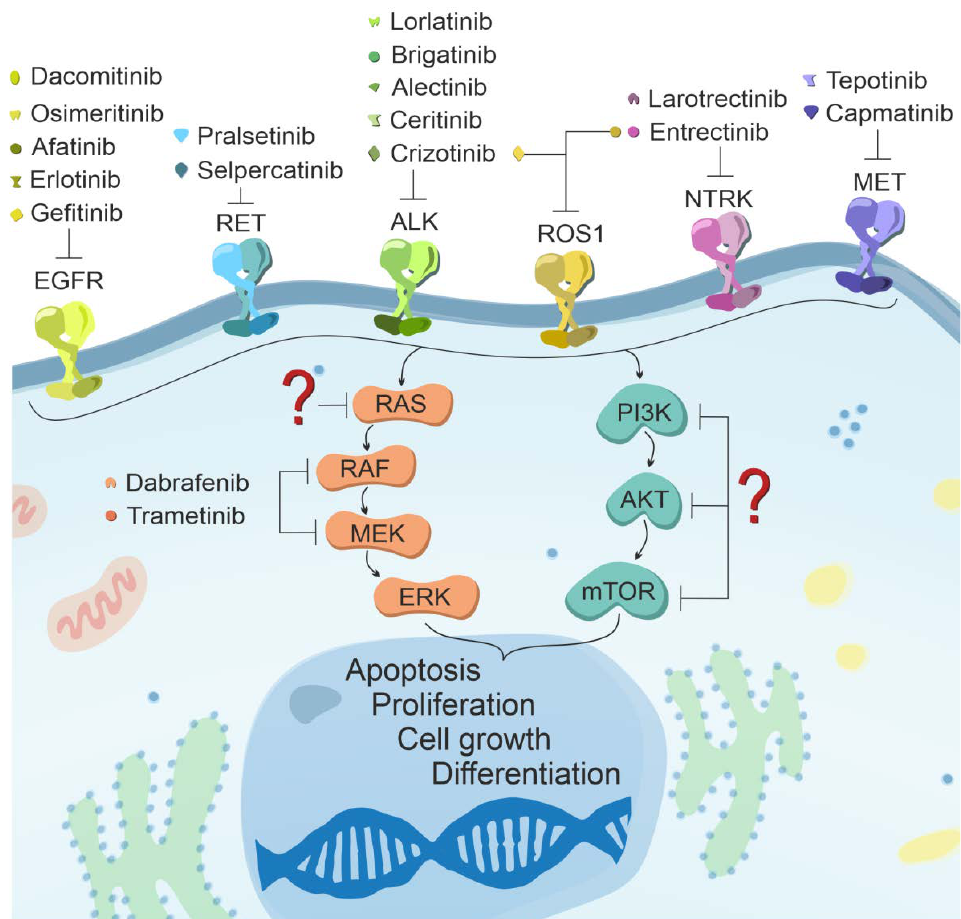
Figure 4. Schematic representation of the leading signaling pathways for which FDA-approved inhibitory substances were developed thus far (EGFR—epidermal growth factor receptor; HER2— human epidermal growth factor receptor 2; ALK—acute lymphoma kinase; ROS1—c-ros1 oncogene; NTRK1—neurotrophic tyrosine kinase receptor type 1; MET—tyrosine-protein kinase Met; RAS—rat sarcoma 2 viral oncogene homologs family; RAF—proto-oncogene c-RAF; MEK—mitogen-activated protein kinase; ERK—extracellular signal-regulated kinases; Pi3K—phosphoinositide 3-kinases; AKT—protein kinase B; mTOR—mechanistic target of rapamycin